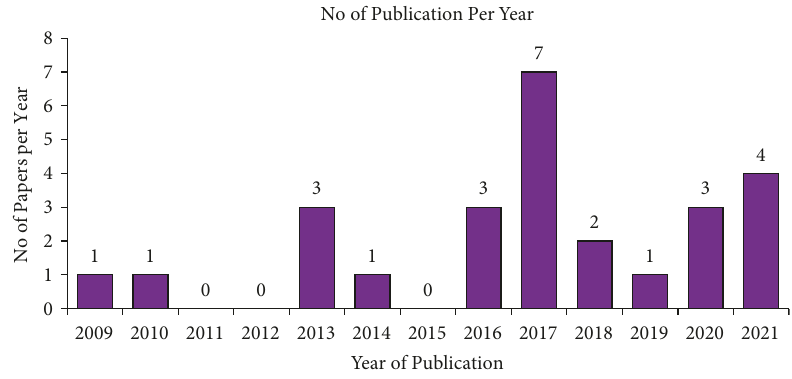
Figure 2: Temporal distributions of studies on HWC in Ethiopia.